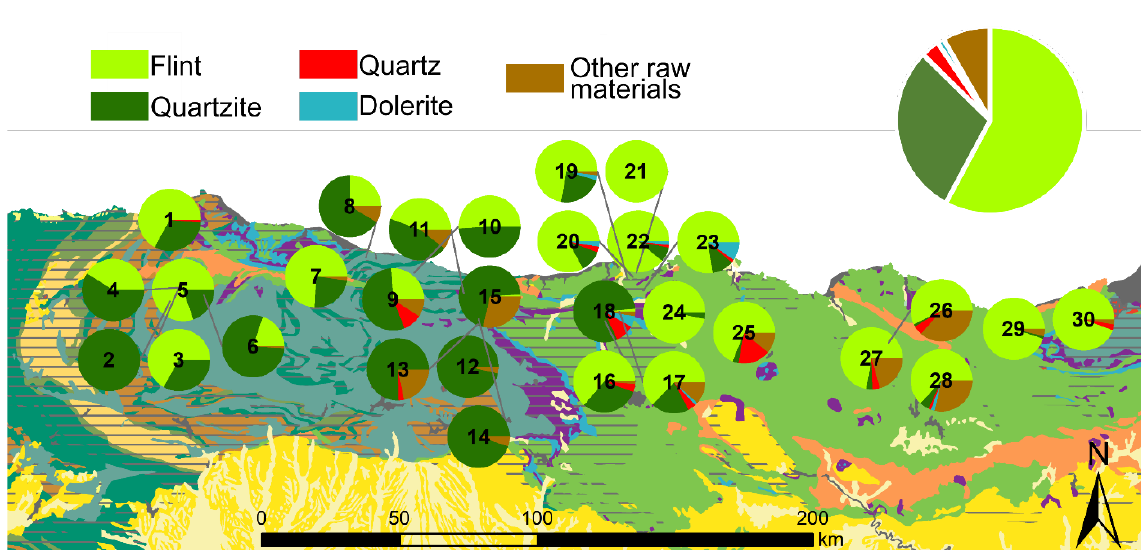
Figure 3. Raw material distribution at each archaeological site using pie charts. The general pie chart in the upper right represents the mean distribution of raw material in the selected sites. Main chrono-lithological strata in the Cantabrian Region are displayed, based on a 1:1.000.000 geological map (Álvaro et al. 1994). The colour of each stratum is the same as in Figure 1. The numbers of the different archaeological sites are also the same as in Figure